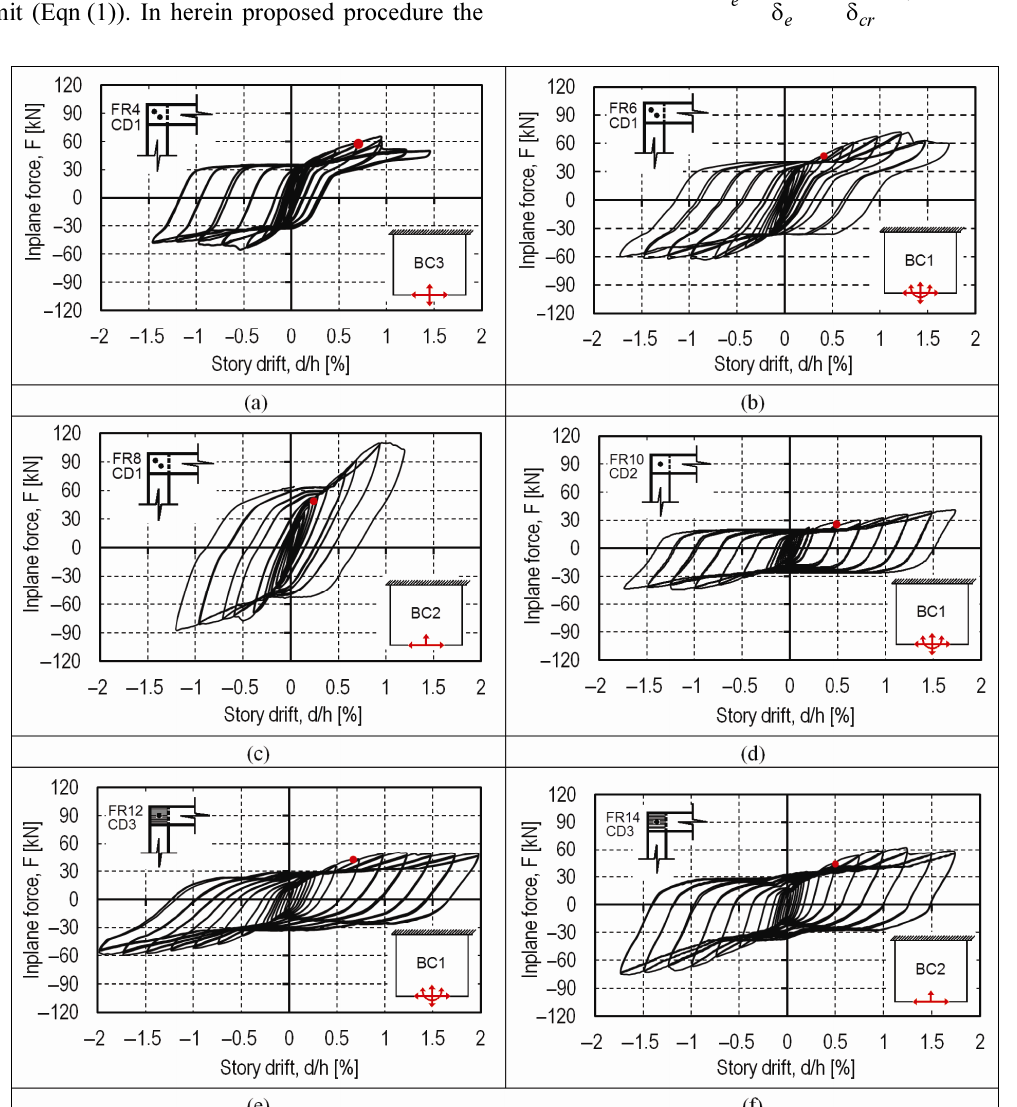
Fig. 5. Hysteresis responses of specimens FR4 (a), FR6 (b), FR8 (c), FR10 (d), FR12 (e) and FR14